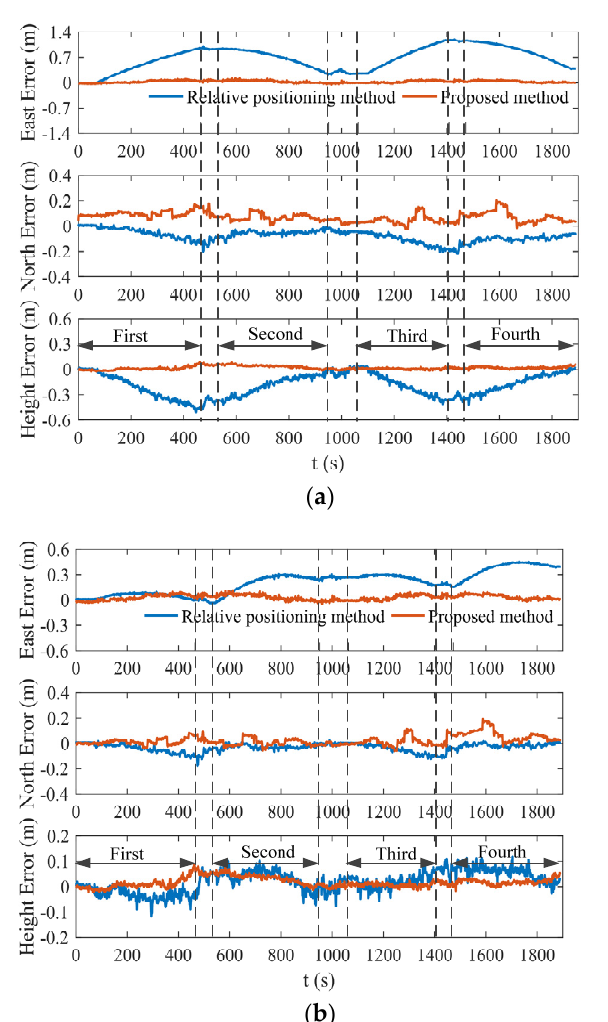
Figure 15. Comparison of positioning errors between the proposed positioning method and relative positioning method: ( a ) positioning errors without calibration of α ; ( b ) positioning errors with calibration of α